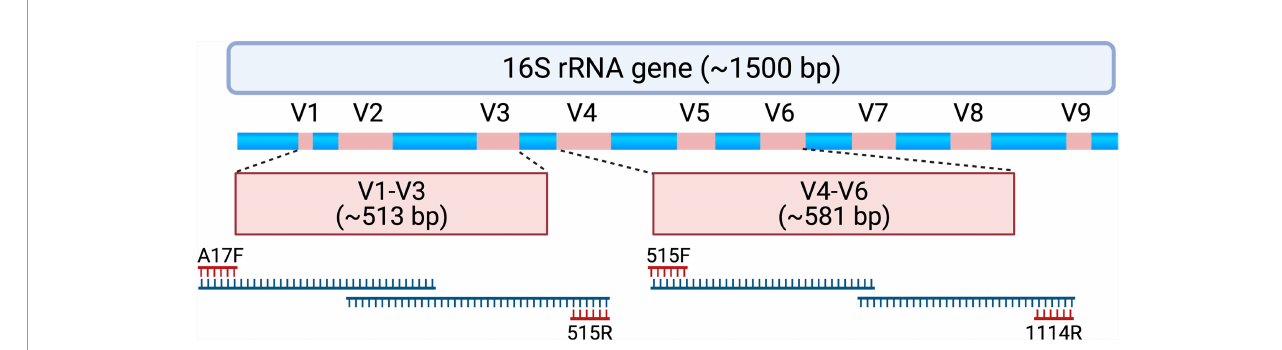
FIGURE 1 | Schematic depicting the 16S rRNA gene and approximate locations of variable regions (V1-V9) that can be selected for amplicon-based sequencing. Samples assessed for this study underwent polymerase chain reaction (PCR) to amplify the V1-V3 region using PCR primers A17F and 515R. When forward and reverse reads are merged, the entire V1-V3 region spans 513 ± 22 base pairs with approximately 87 base pairs of overlapping sequence. Samples also underwent PCR to amplify the V4-V6 region using PCR primers 515F and 1114R. When forward and reverse reads are merged, the entire V4-V6 region spans 581 ± 2 base pairs with approximately 19 base pairs of overlapping sequence. For this study, forward and reverse reads were generated on an Illumina MiSeq platform, which creates sequencing reads of approximately 300 base pairs in length. The initial and fi nal portions of each sequencing read tend to contain lower quality sequence (i.e., lower con fi dence scores with nucleotide assignment) that could be adjusted or truncated in a DADA2 processing pipeline. As such, paired end reads without a substantial amount of overlapping sequencing may not be able to be merged. Created with